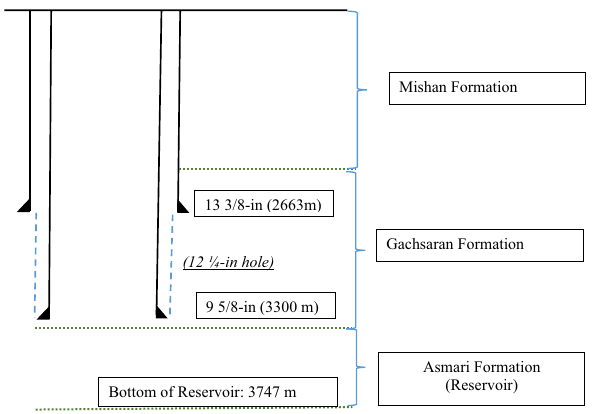
Fig. 6 Schematic of well Z26 of Kupal oilfield (for the 12 ¼-in. hole across Gachsaran formation)